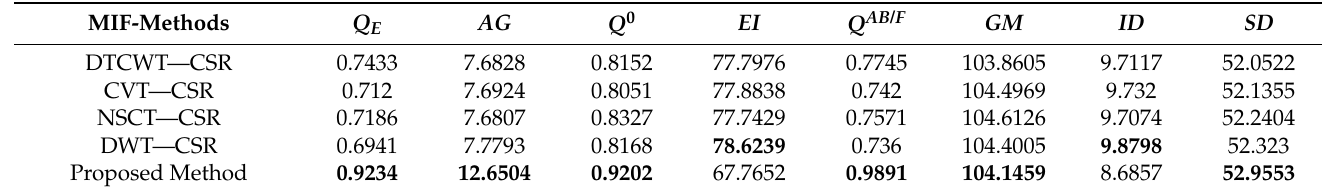
Table 12. The average objective evaluation of different techniques on multi-focus image pairs ([22]).